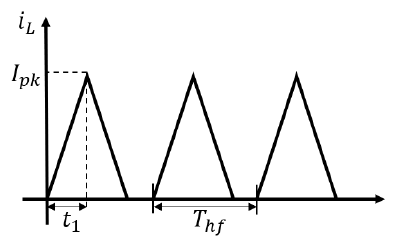
Figure 12. Inductor current.